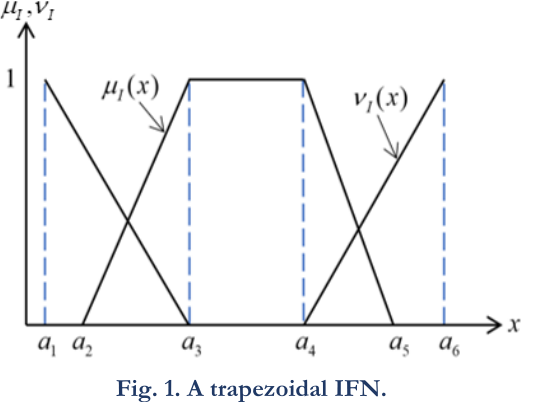
Fig. 1. A trapezoidal